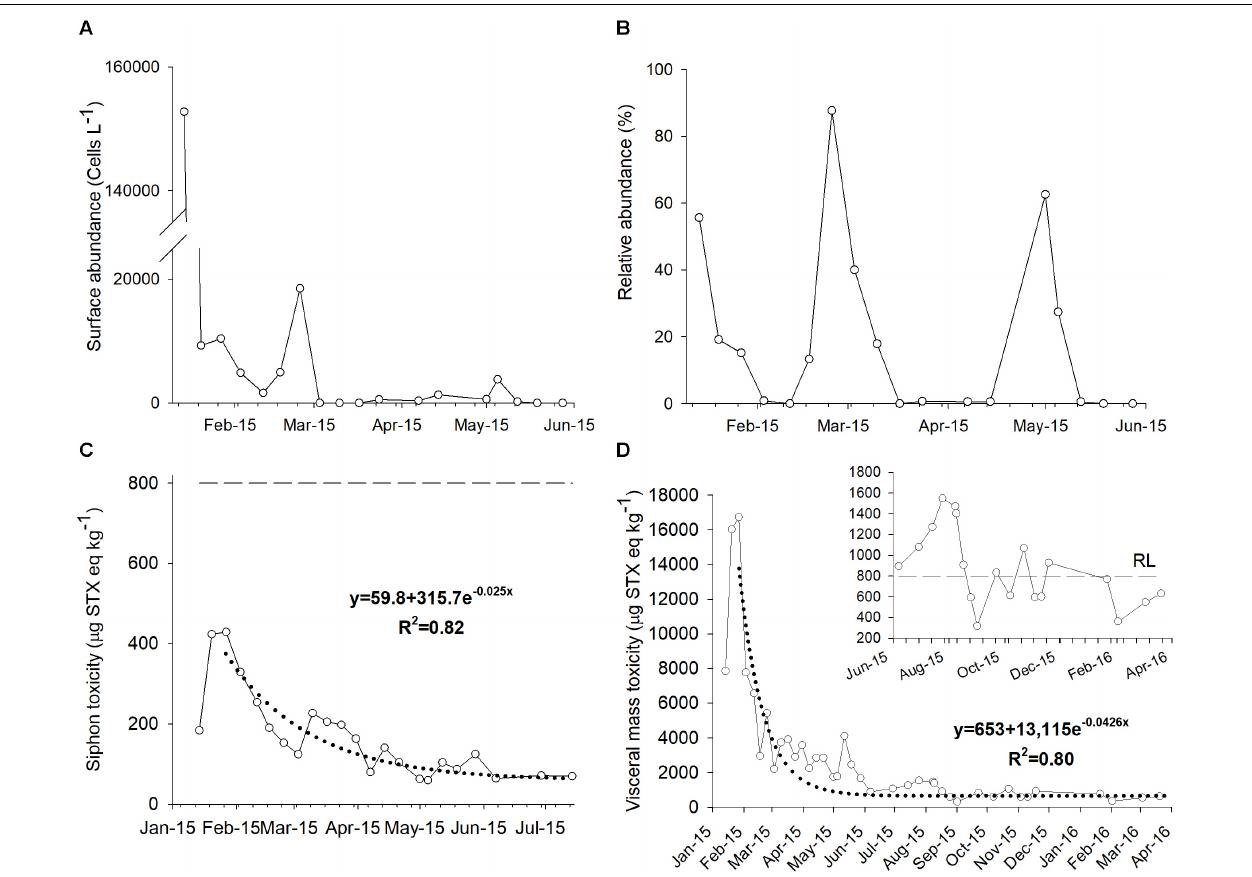
FIGURE 3 | Surface (A) and relative abundance (B) of Gymnodinium catenatum during 2015 in the northern region of the Gulf of California. Toxicity associated with paralytic shellfish toxins in the siphon (C) and visceral mass (D) of geoduck samples collected from January 2015 to April of 2016. Dotted line shows the fitted of exponential decay function to the data and the dashed line is the regulatory limit (RL) of 800 µ g STX eq kg − 1 .